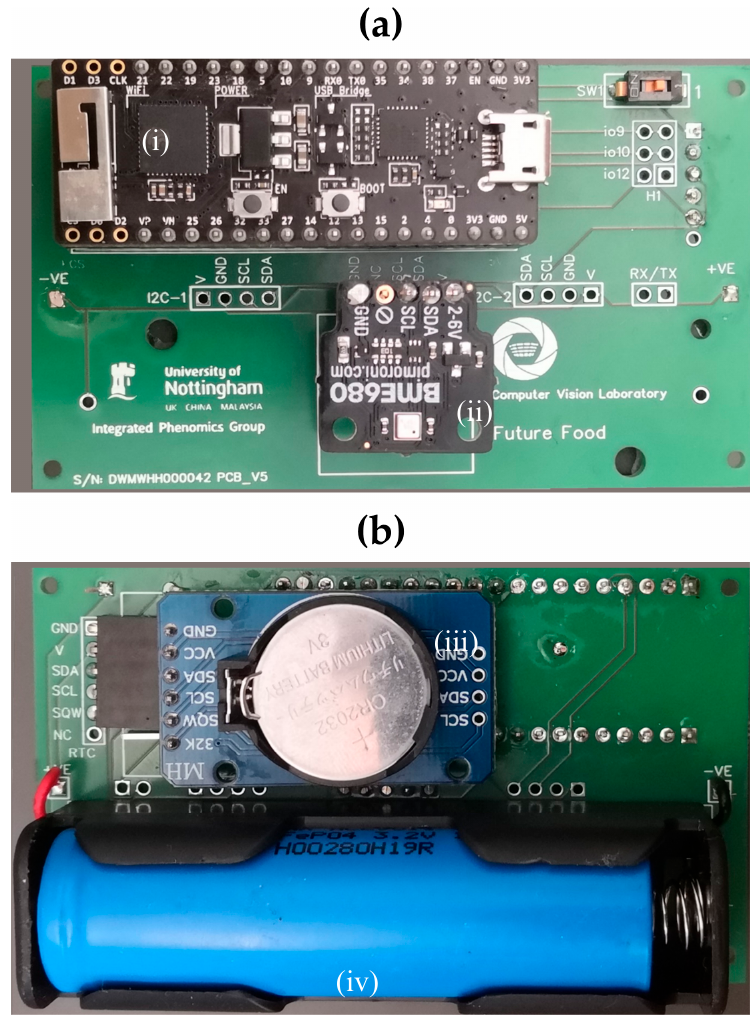
Figure 6. ( a ) Sensor printed circuit board (PCB) top side. ( b ) Bottom side. Main components: (i) ESP32 development board, (ii) sensor daughter board, (iii) real-time clock module, and (iv) LiFePO 4 rechargeable battery. Table 4. Sensor and logging characteristics.